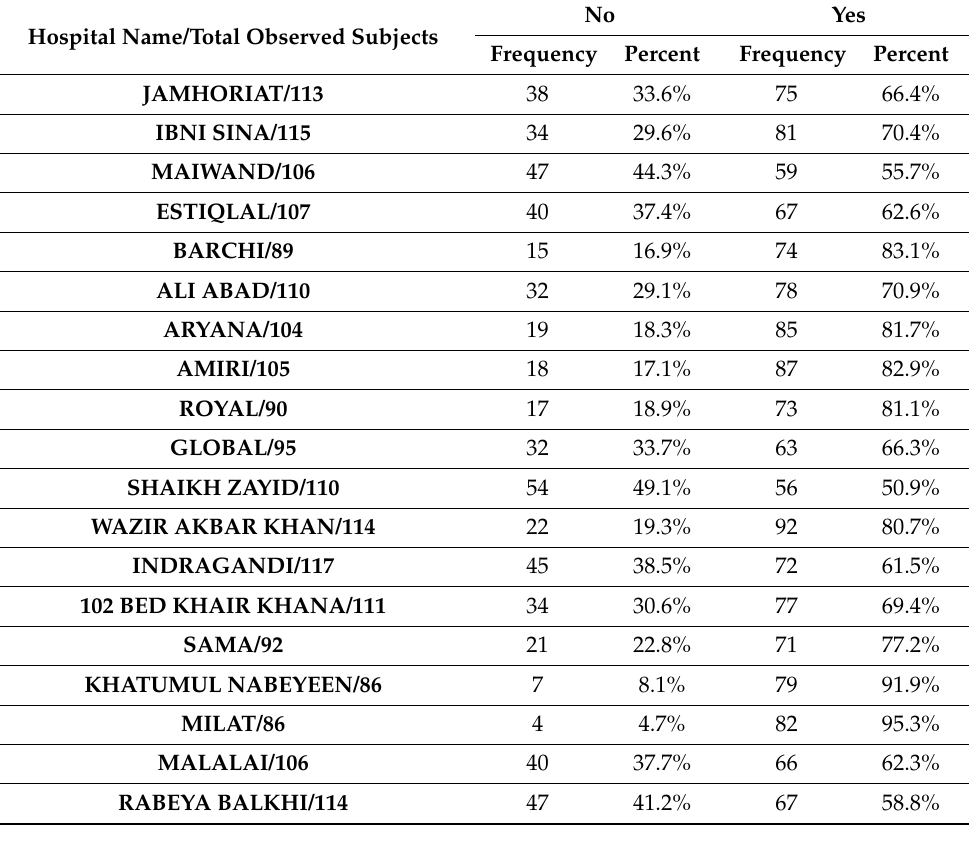
Table 2. Mask usage based on the hospital’s visitors.